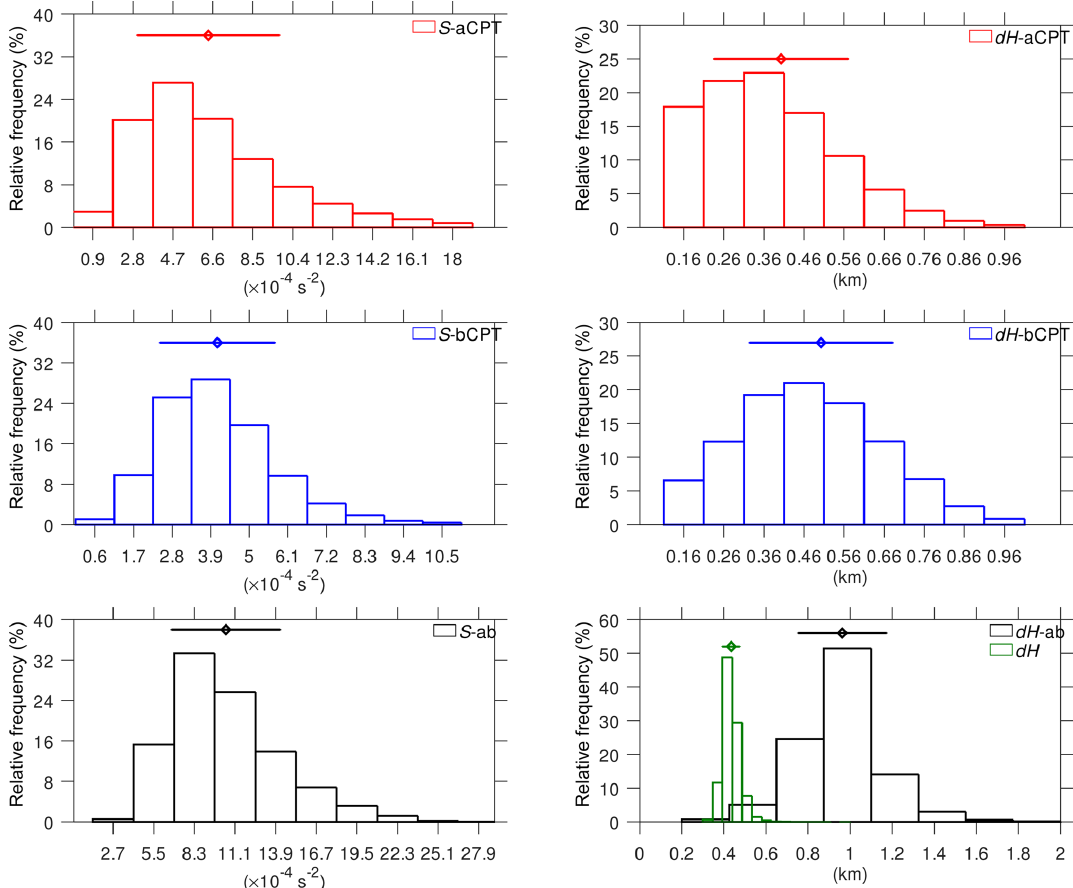
Figure 5. Frequency distribution of TIL parameters with respect to the vertical distance from the CPT. The diamonds and horizontal lines above each histogram represent the mean and standard deviation of each parameter,